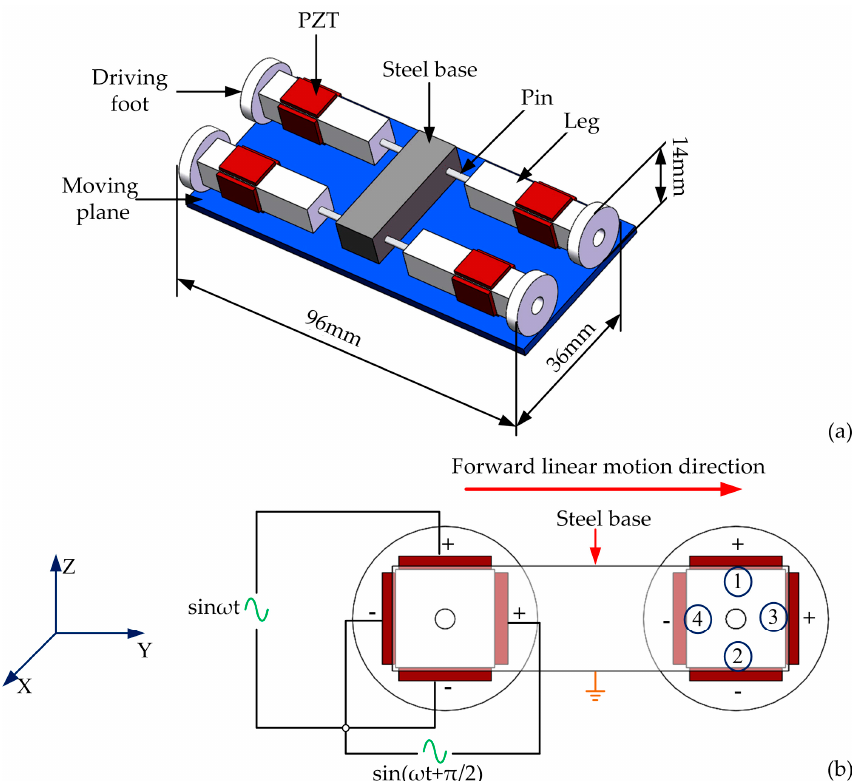
Figure 1. The structure and exciting method design: ( a ) The basic structure of micro-robot; ( b ) The exciting signals.